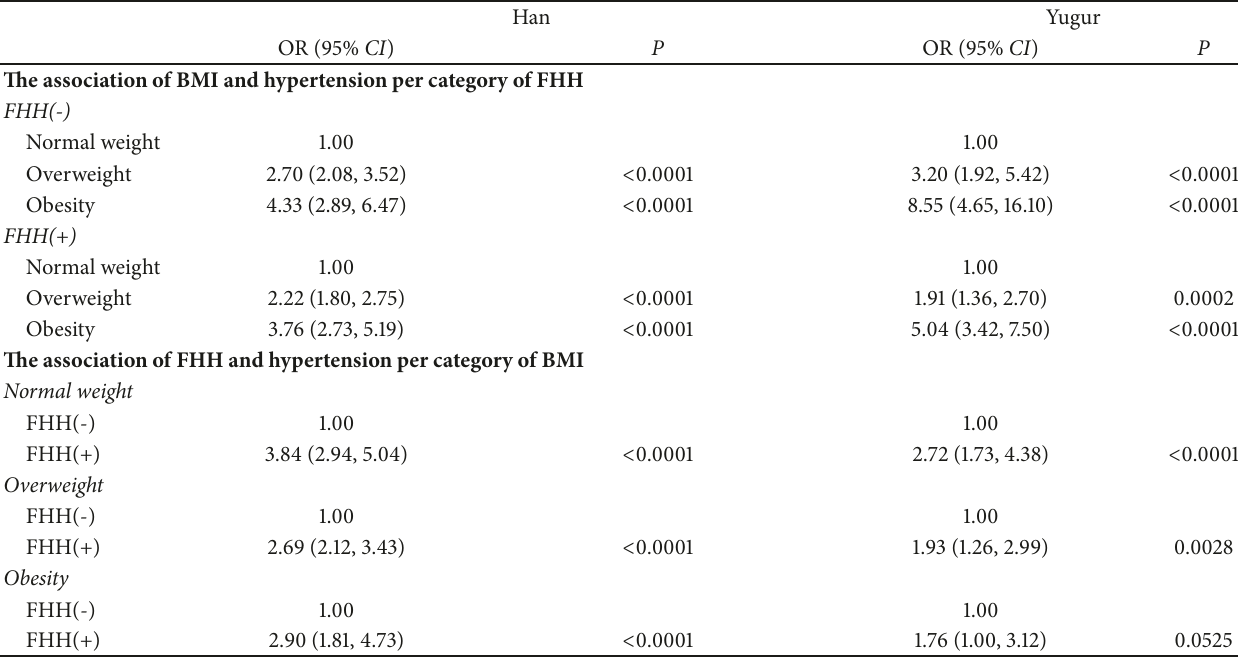
Table 2: Associations of BMI with hypertension per category of FHH and associations of FHH with hypertension per category of BMI in Han and Yugur people in